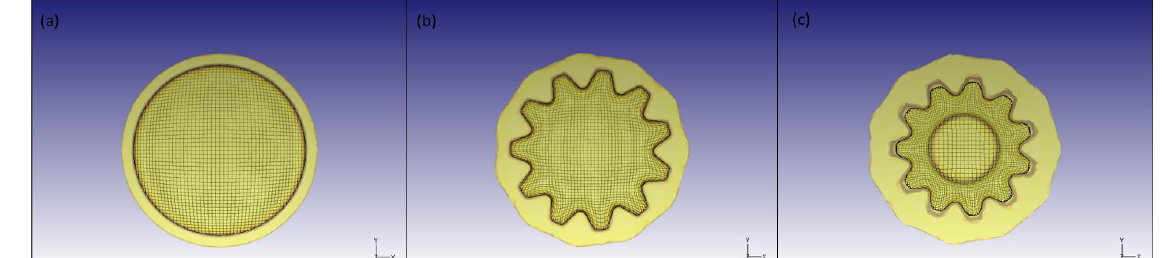
Figure 20. Deformed grid pattern flow line in the forged pinion head from top view: ( a ) Actual forged head, ( b ) Forged head with teeth, ( c ) Forged head with teeth and punched hole.